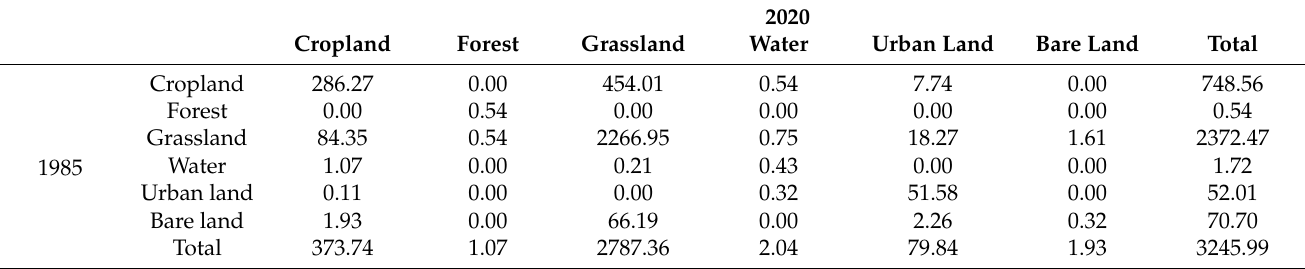
Table 1. Transition matrix of land-use changes in the Huangfuchuan Watershed from 1985 to 2020.